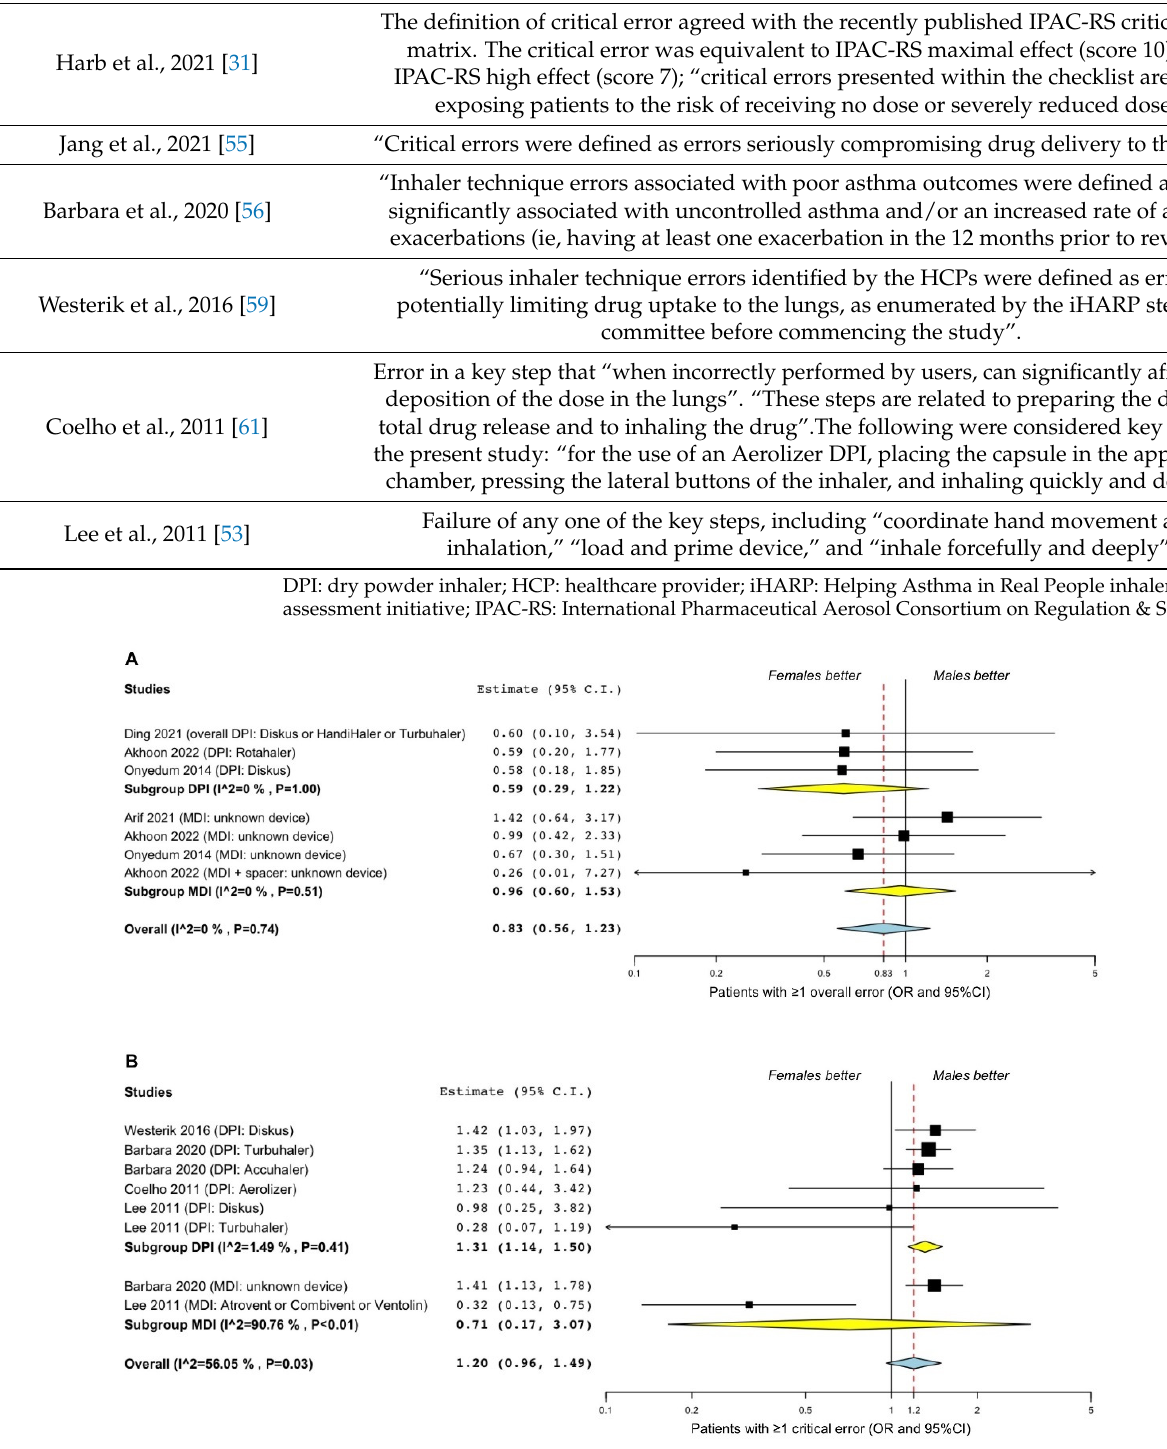
Figure 2. Forest plots of the association between the frequency of making at least one overall error ( A ) [51,52,54,60] or one critical error ( B ) [53,56,59,61] in the use of inhaler devices in asthma. DPI: dry powder inhaler; MDI: metered-dose inhaler; OR: odds ratio; 95%CI: 95% confidence interval. There was a trend towards significance ( p = 0.11) in the association of female sex with making at least one critical error in the use of inhaler devices (OR 1.20; 95%CI 0.96–1.49; I 2 56.05%; GRADE ++), which was mainly driven by the effect estimate resulting for DPI (Figure 2B). In this regard, the subgroup analysis indicated that significantly ( p < 0.01) more female than male patients made at least one critical error in the use of DPI (OR 1.31, 95%CI 1.14–1.50; I 2 1.49%; GRADE +++), whereas no significant ( p > 0.05) difference be- tween sexes was detected for MDI (Figure 2B). The substantial and significant level of heterogeneity (I 2 90.76%, p < 0.01) detected in the subgroup analysis for MDI could not be resolved as only two studies [53,56] were included. 3.2.2. COPD No significant ( p > 0.05) difference was observed between females and males in mak- ing at least one overall error in the use of inhaler devices (OR 0.93, 95%CI 0.76–1.15; I 2 0%; GRADE ++) (Figure 3A). The subgroup analysis indicated no significant ( p > 0.05) differ- ence by sexes in the improper use of DPI and MDI, and no substantial heterogeneity was detected (Figure 3A). Female sex was significantly ( p < 0.05) associated with making at least one overall error in the use of SMI (OR 9.09, 95%CI 1.15–71.98; GRADE +++), but the effect estimate resulted from only one study [31], and thus heterogeneity was not esti- mated (Figure 3A).